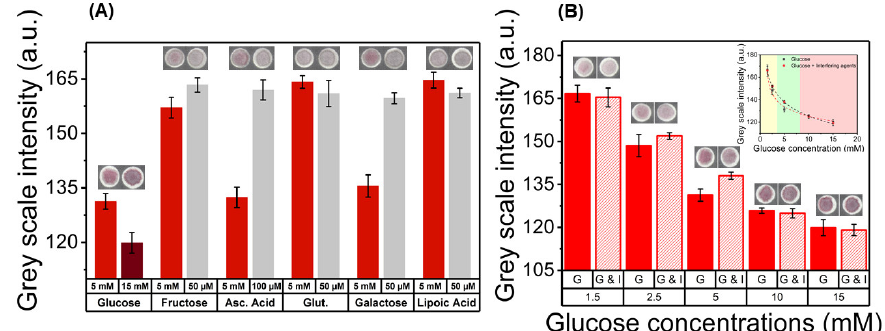
Figure 5. Interference assay for assessment of specificity towards glucose. ( A ) Color signals produced using glucose and common reducing agents individually. ( B ) Color signals obtained for standard samples containing glucose and interfering agents (G & I), with concentration in the physiological levels, are compared with signals containing glucose individually (G) showing the effect of these interfering agents. The plot of correlation between grey scale value and glucose concentrations are presented in inset.